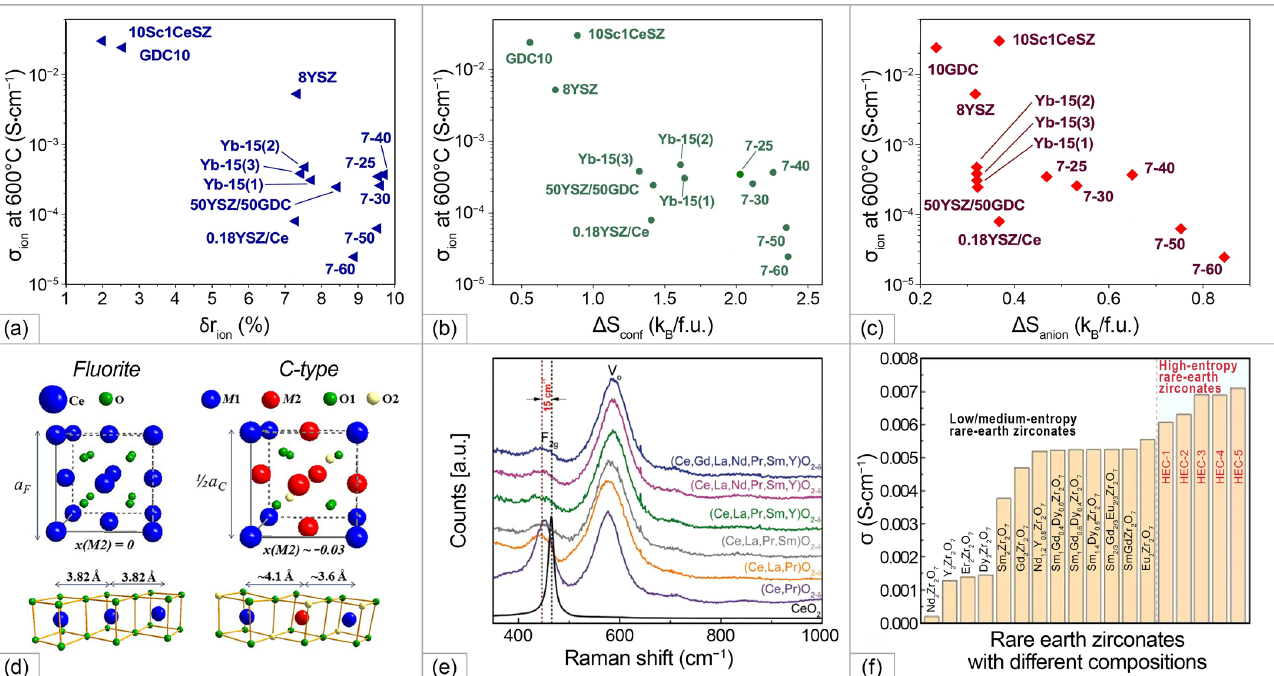
Figure 13. Dependence of the ionic conductivity of some HE and conventional solid oxide electrolytes on ( a ) ∆ S conf ; ( b ) δ r ion ; ( c ) ∆ S anion ; ( d ) schematic representation of fluorite and C-type structures; ( e ) Raman spectra of pure CeO 2 and different CeO 2 -based rare earth oxides; ( f ) conductivity of low, middle and high-entropy zirconates (( a – c ) are adapted from [165]; ( d ) is adapted and reproduced from [170]; ( e ) is adapted from [119] with permission of The Royal Society of Chemistry; ( f ) is adapted from [171] with permission of Elsevier).